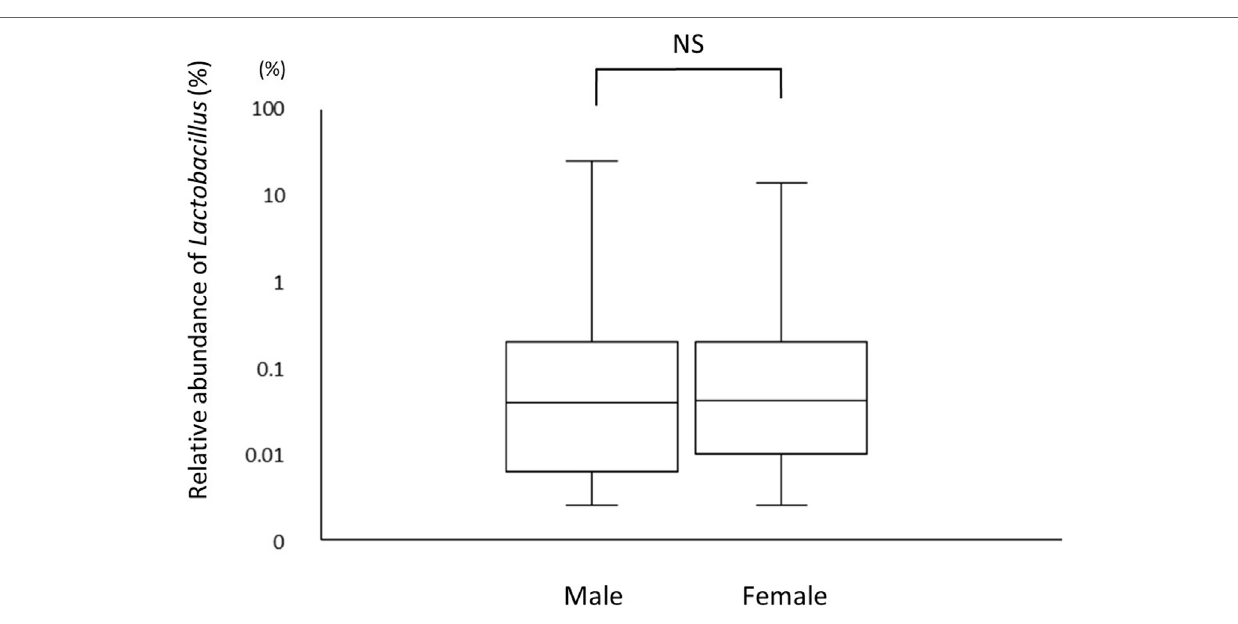
FigUre 3 | The relative abundances of Lactobacillus in gut microbiota in male and female.